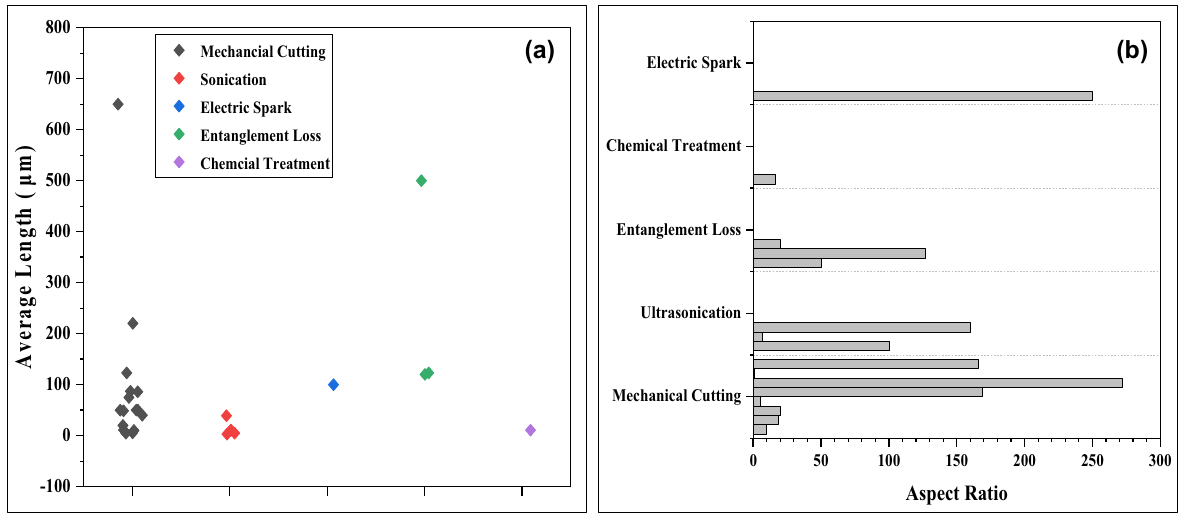
Figure 11: ( a ) Average length and ( b ) aspect ratio o ff ered by diverse short nano fi ber preparation